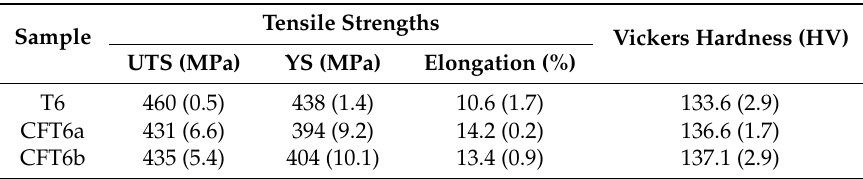
Table 1. Mechanical properties of T6, CFT6a and CFT6b samples.